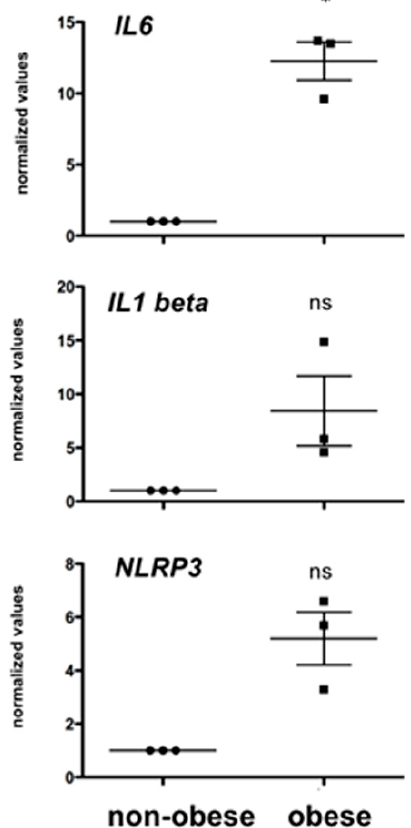
Figure 2. Levels of testicular Interkeulin 6 ( IL6) were significantly elevated in testes of obese monkeys, while higher levels of Interleukin 1 beta ( IL1beta ) or the inflammasome NLRP3 did not reach statistical significance; n = 3, * p < 0.05; ns: not statistically significant. The data of the obese animals ( n = 3) are given as individual levels and as the mean ± SEM. The values were normalized to the levels of the controls group (pooled results of n = 6 non-obese monkeys).